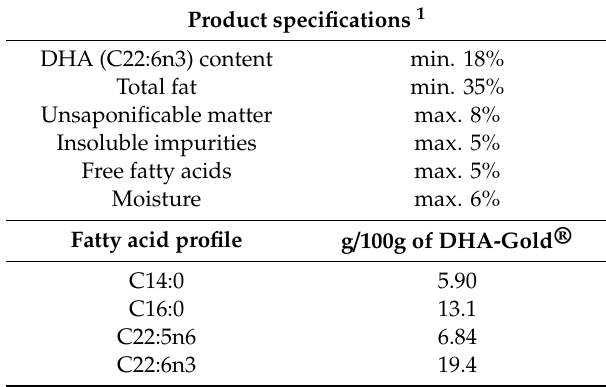
Table 2. Product specifications and fatty acid profile of DHA-Gold ® (DHA-Gold ® , Martek Biosciences, MD, USA), showing only fatty acids greater than 1% of the total fatty